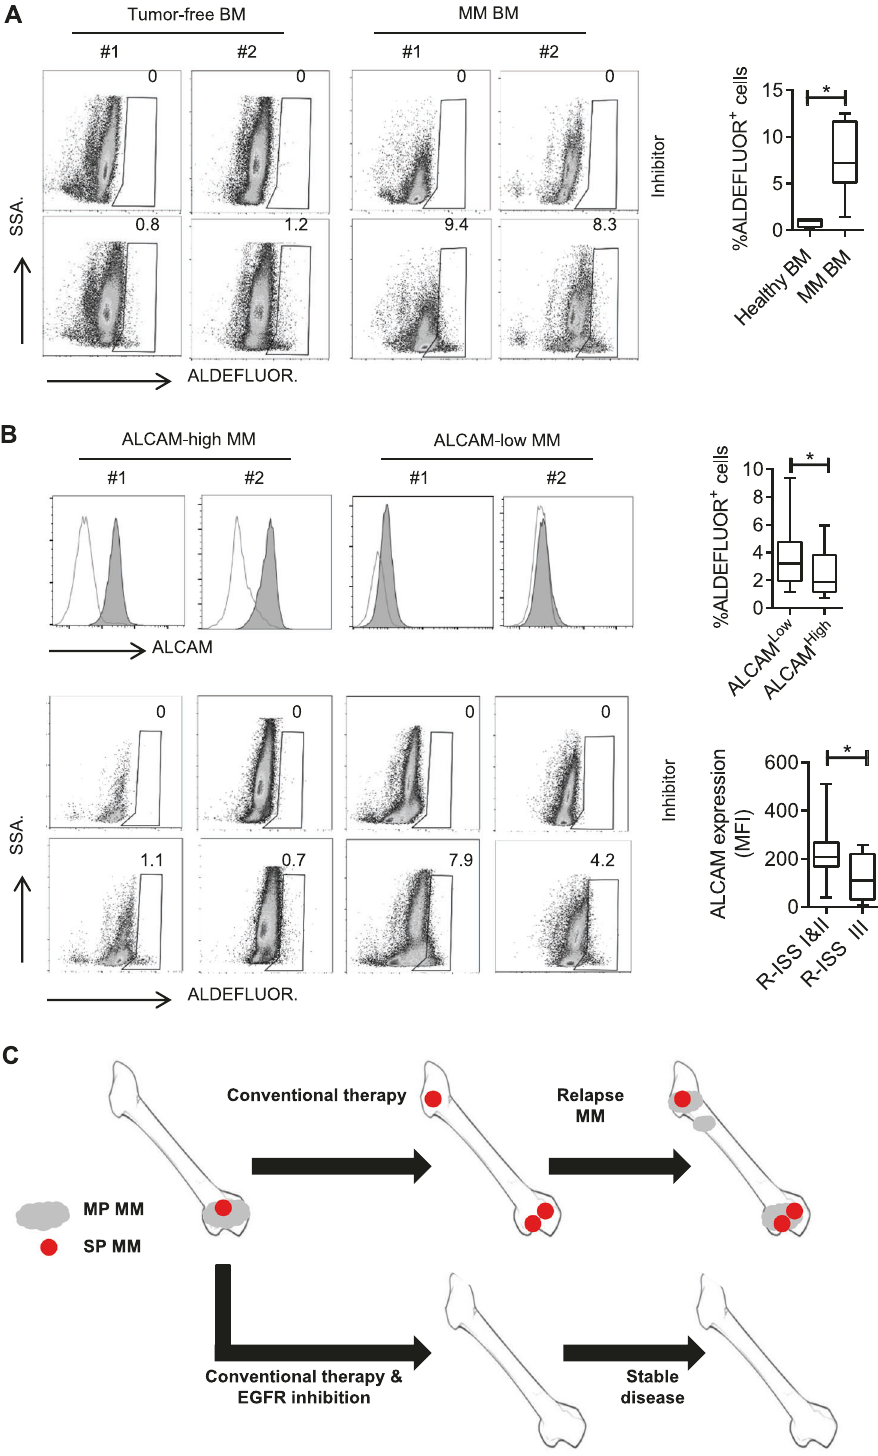
Fig. 7 ALCAM expression and stemness myeloma cells. A ALDEFLUOR analysis of BM cells from non-tumorous donors ( n = 5) and MM patients ( n = 7). Two representative results are shown. B BM cells from 42 newly diagnosed MM patients were analyzed by fl ow cytometry for ALCAM expression in CD138 + MM cells and ALDEFLUOR staining. Results show 2 representatives of ALCAM-high MM versus ALCAM-low MM, and corresponding ALDEFLUOR staining results. C Graphic model of EGFR-targeting therapy in MM treatment (* p < 0.05). The patients with ALCAM Low MM had a higher ratio of in a group of primary MM cells. The patient characteristics are summarized in Supplementary Table 2. ALCAM expression in ALDFLUOR + cells than patients with ALCAM High MM (Fig. 7B); primary MM cells was determined by RT-qPCR. The patients R-ISS III MM patients had more ALDFLUOR + cells than R-ISS I&II were divided into two groups according to ALCAM expression. patients (Fig. 7B). To summarize, our data show the existence of Cell Death and Disease (2022)